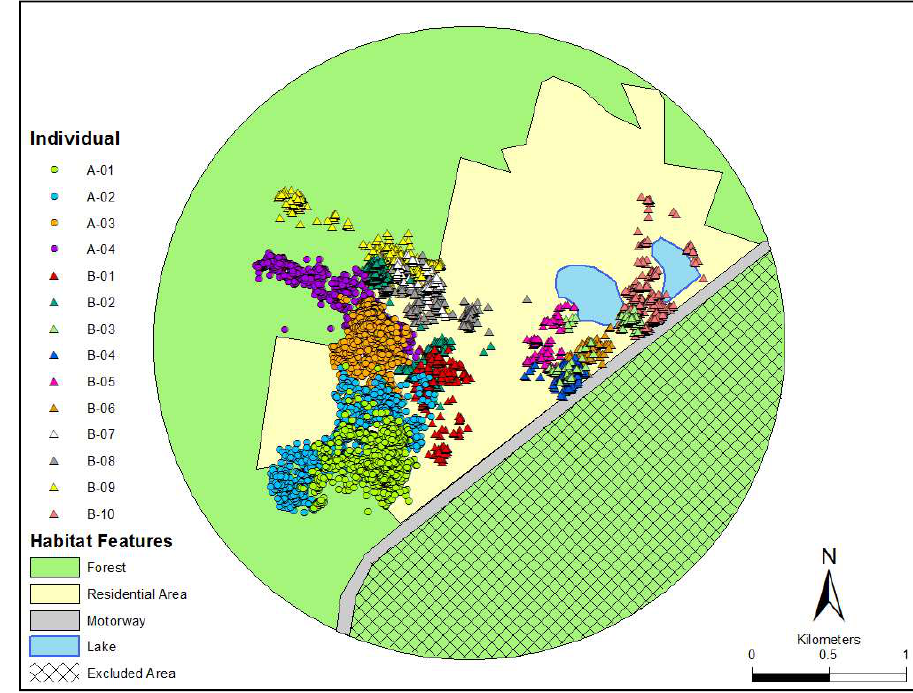
Figure 1. The circle defines the ‘study area’ with location fixes for all individuals, in relation to habitat type (forest and residential area).